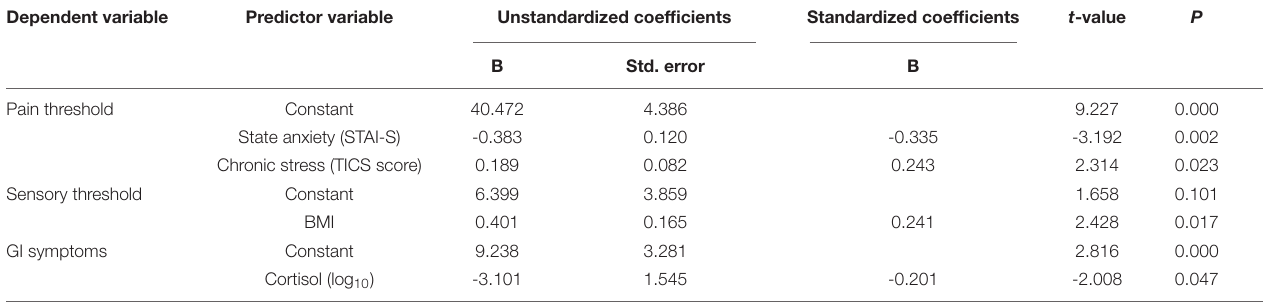
TABLE 2 | Results of multiple regression analysis (stepwise